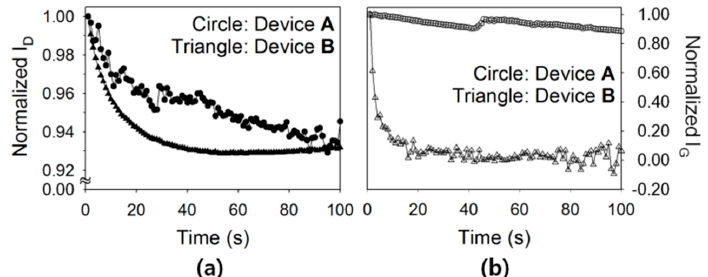
Figure 4. Time-dependent decay behaviors of the ( a ) drain and ( b ) gate currents of the flexible TIPS-pentacene TFTs, during a prolonged bias stress test.